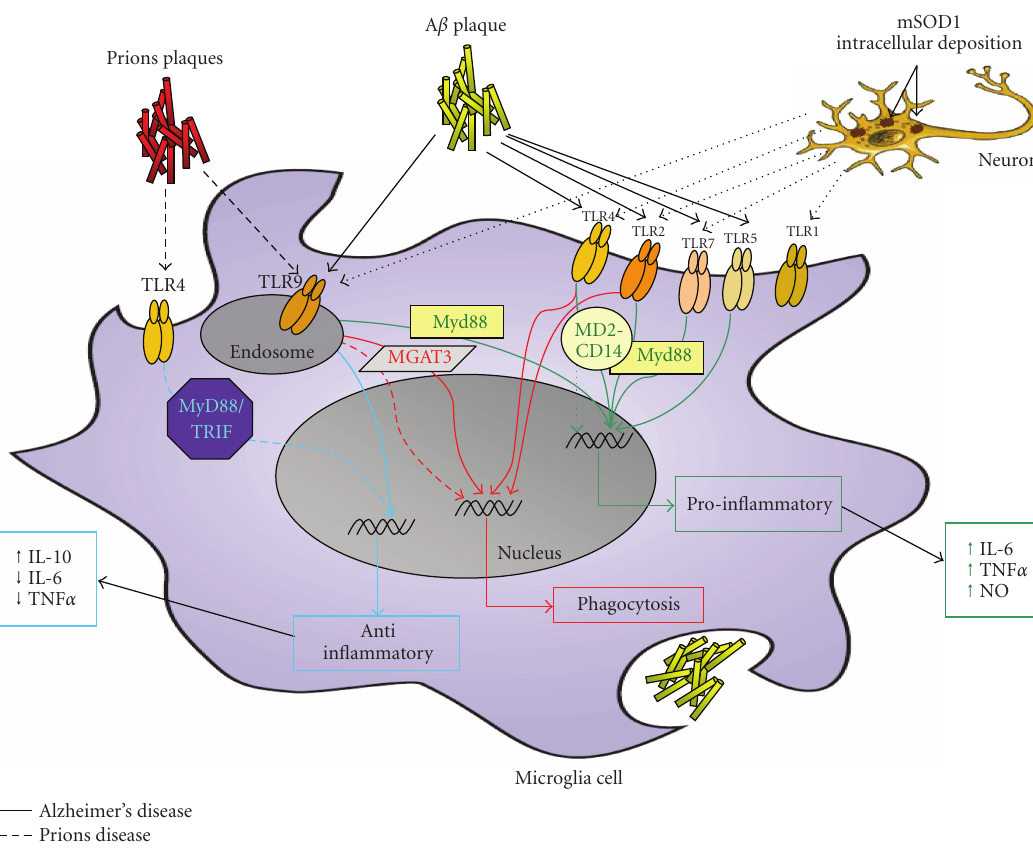
Figure 1: Microglia TLR signaling in neurodegenerative diseases. Abnormal amyloid deposition in di ff erent neurodegenerative diseases may activate microglial cells through TLRs. Microglial activation may lead to further neuronal damage through secretion of proinflammatory cytokines (green), such as IL-6 and TNF- α , or to neuroprotection by secretion of anti-inflammatory cytokines (blue), such as IL-10, which may prevent further neuronal death. Furthermore, recent reports suggest the role of TLRs 2, 4, and 9 signaling in modulating the phagocytosis (red) and clearance of the neurotoxic amyloid